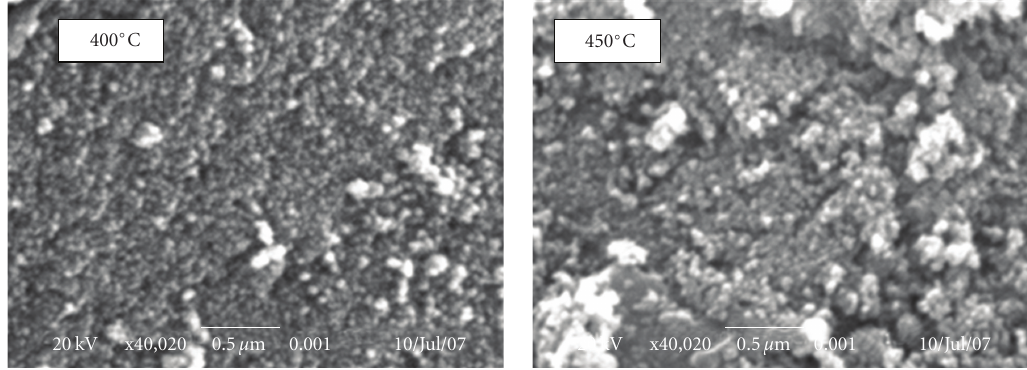
Figure 4: SEM Images of nanoporous TiO 2 calcined at 400 ◦ C and 450 ◦ C.